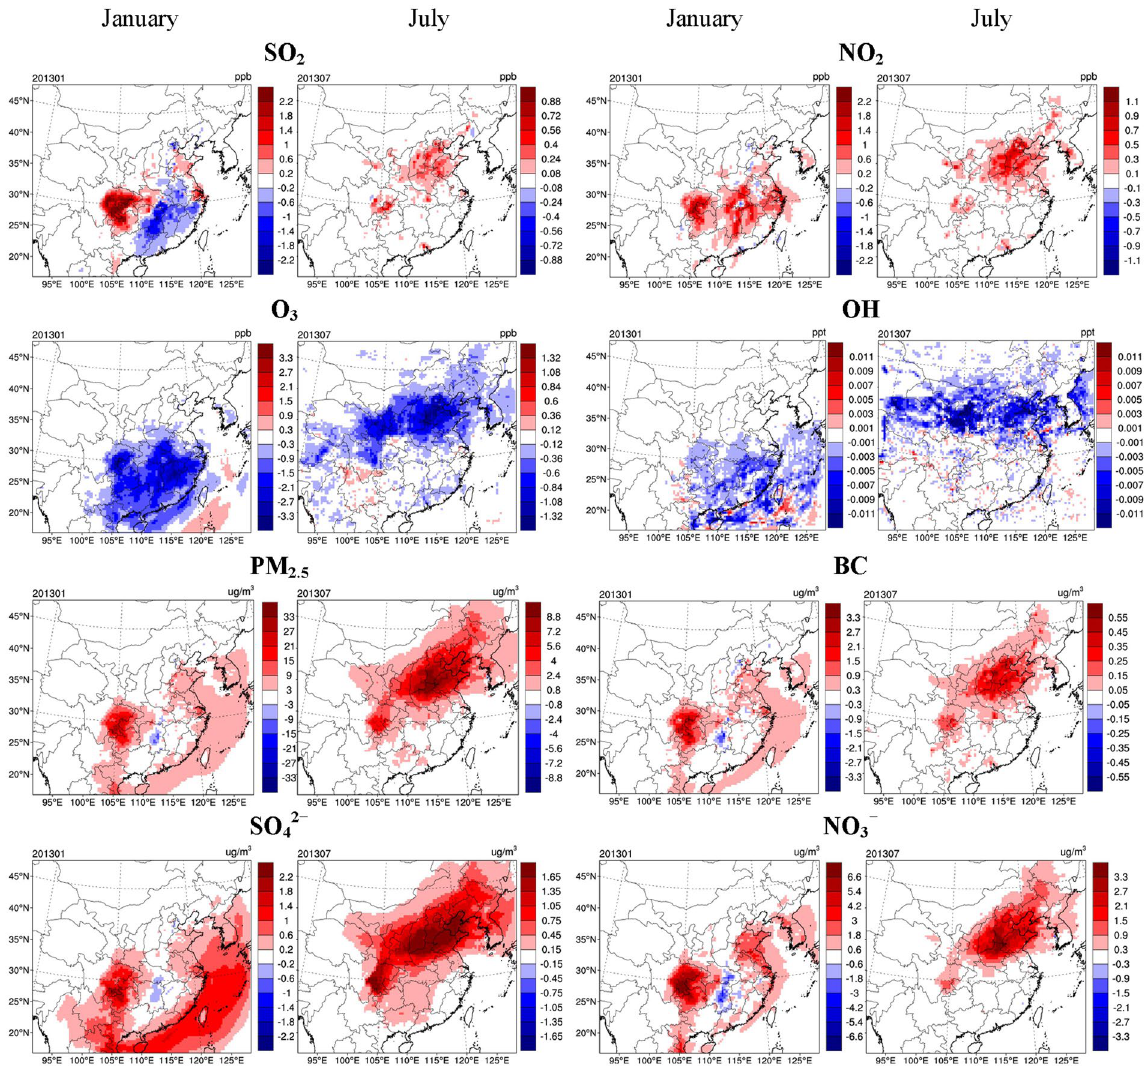
Figure 3. Same as Fig. 2, but for concentrations of gaseous pollutants, PM 2.5 , and major PM 2.5 chemical components, including black carbon (BC), SO 42– , and NO 3 − . This figure is produced using the NCAR